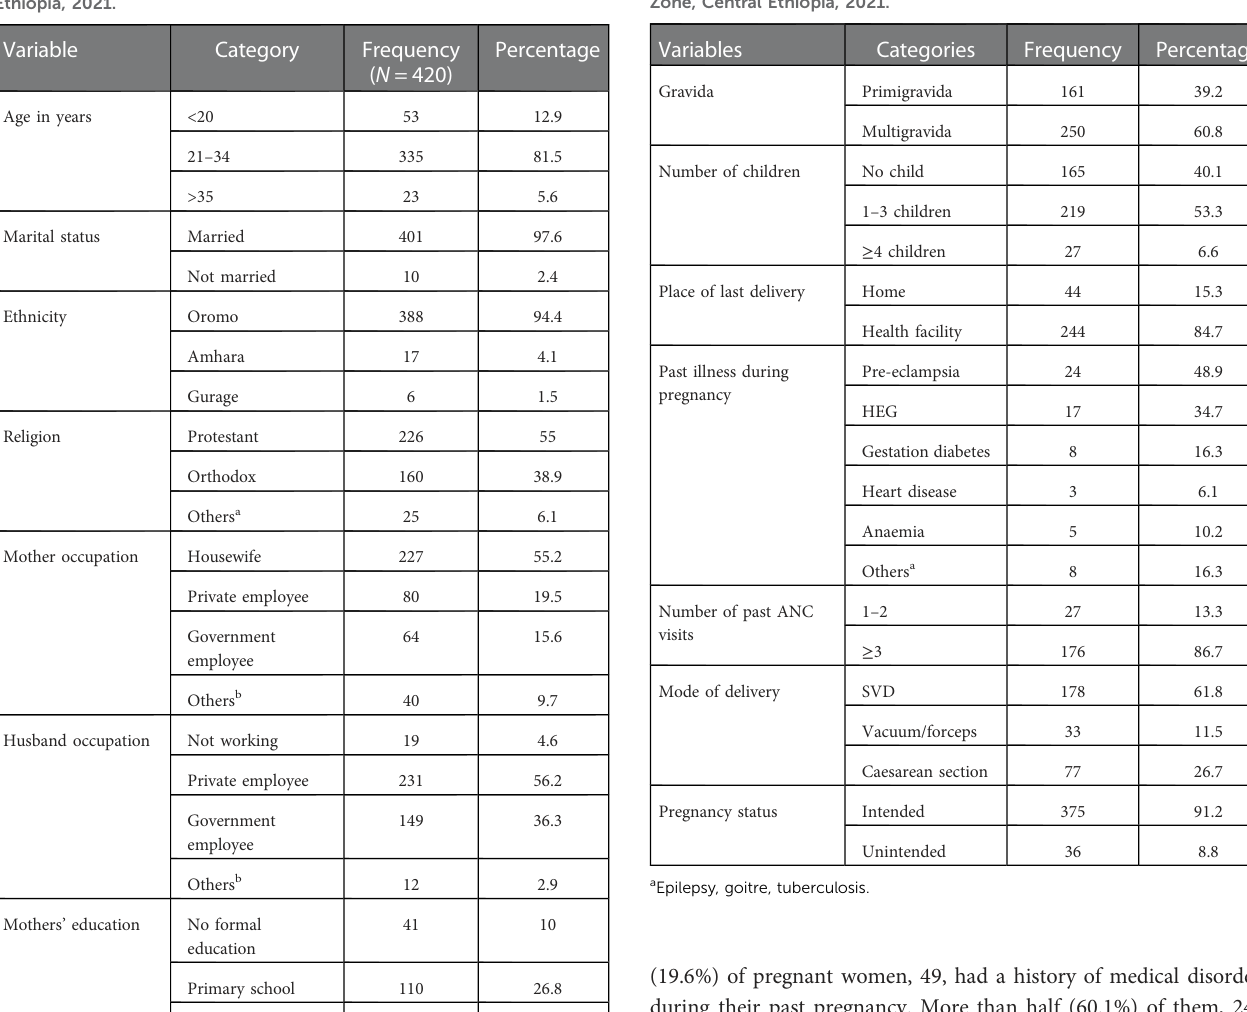
TABLE 2 Obstetrics and reproductive health characteristics of pregnant women receiving ANC service at public health facilities in the West Shewa Zone, Central Ethiopia, 2021.